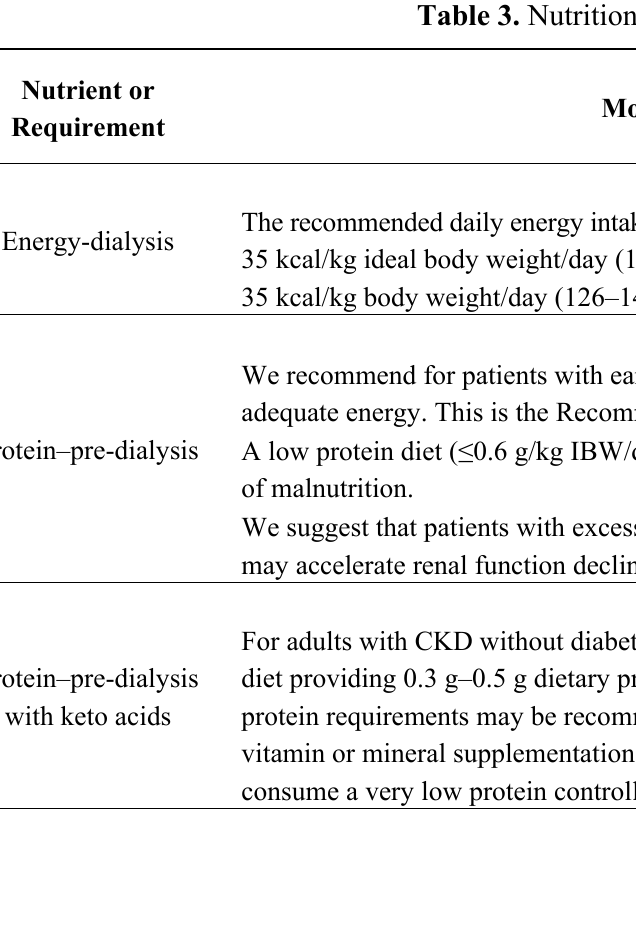
Table 3. Nutritional Parameter in International Guidelines with